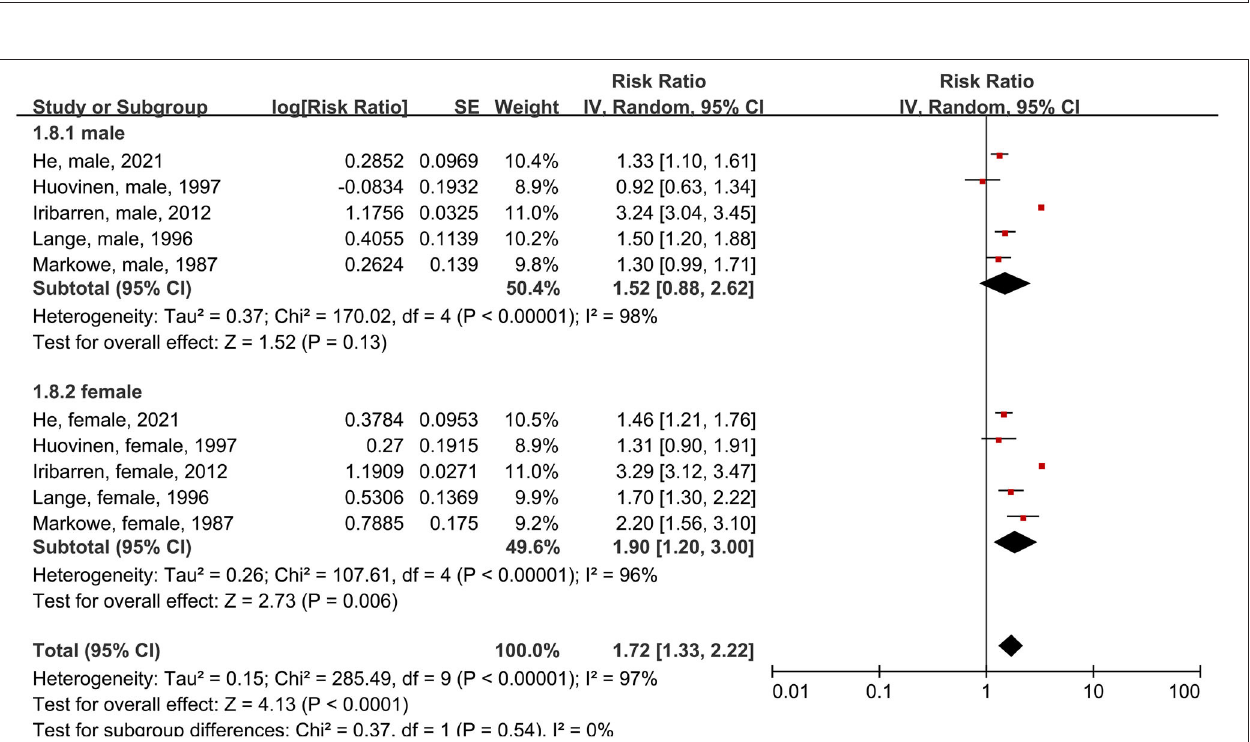
Frontiers in Cardiovascular Medicine |